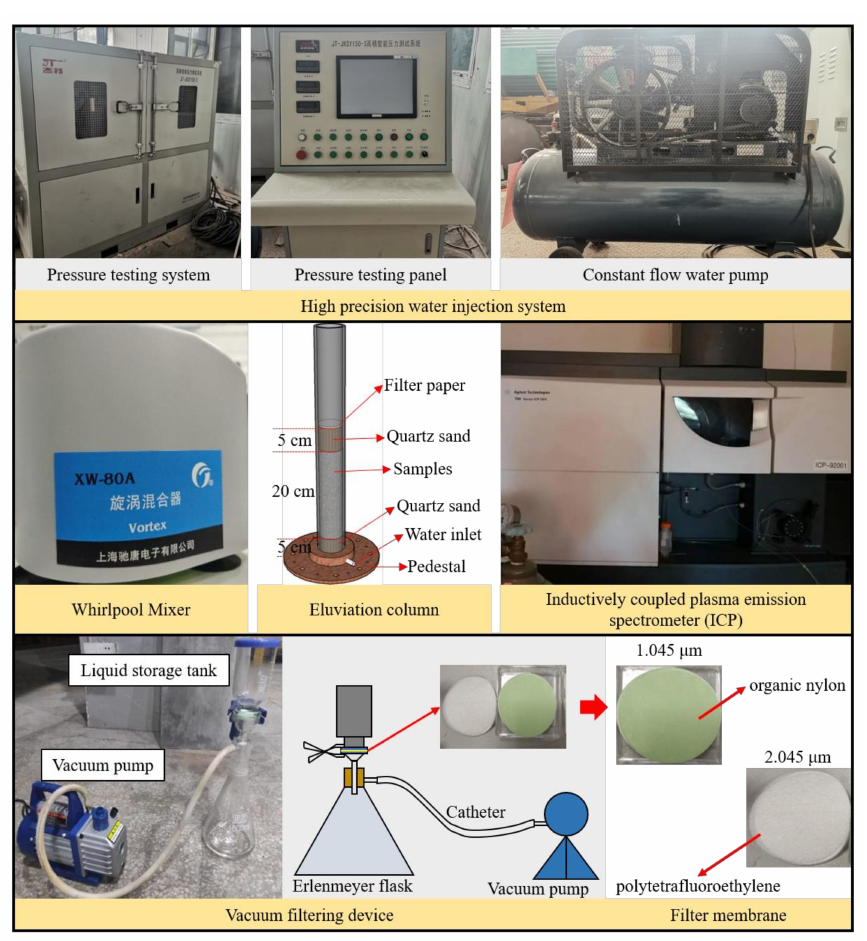
Figure 7. Testing